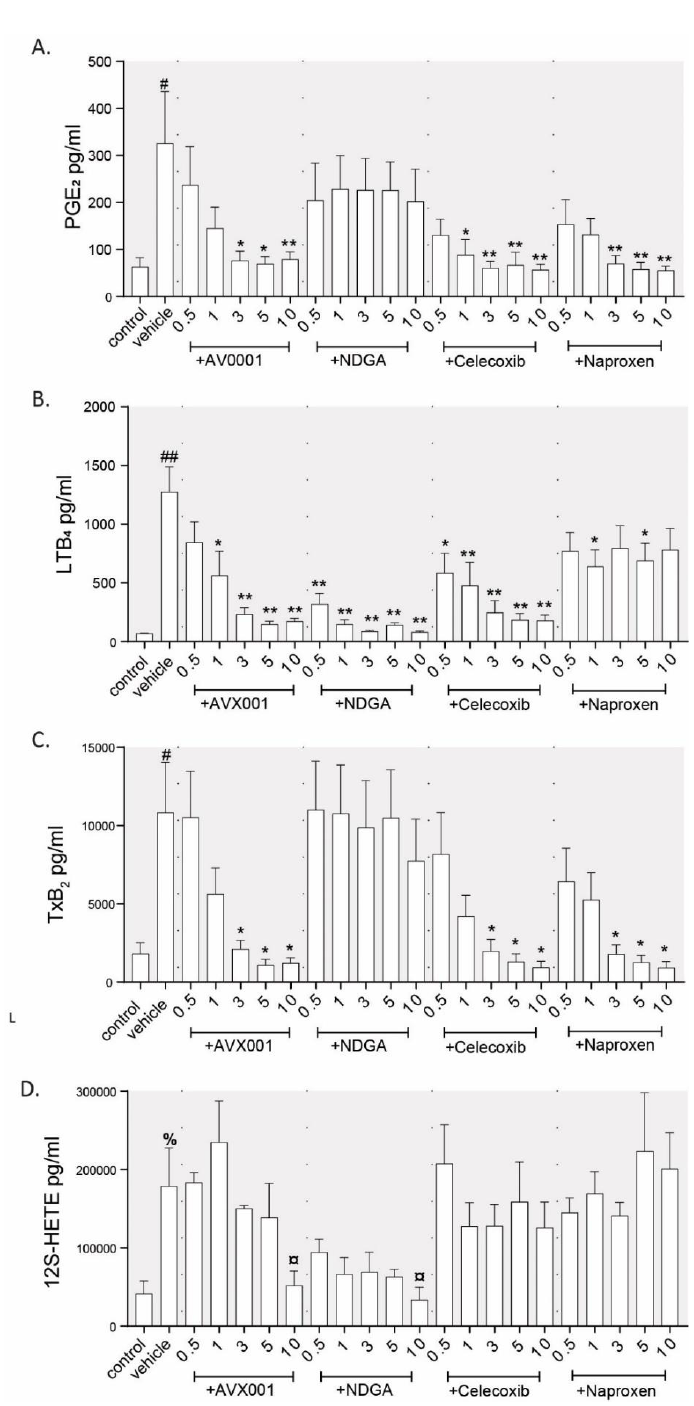
Figure A1. Inhibition of eicosanoid release in A23178-stimulated PBMC. Eicosanoid levels were measured in the supernatants of PBMC pre-incubated with vehicle, AVX001, naproxen, celecoxib, or NDGA in the range of 0.5 – 10 µM, and stimulated with A23178 (30 µM, 15 min). Data are the mean ± SEM for ( A ) PGE 2 , ( B ) LTB 4 , ( C ) TxB2, and ( D ) 12S-HETE from four individuals (PGE 2 , LTB 4 , TxB2) or three individuals (12S- HETE). Statistical significance was calculated using ANOVA with Dunnett’s post-analysis, whereby % p < 0.1, # p < 0.05, ## p < 0.01 versus unstimulated control and ¤ p < 0.1, * p < 0.05, ** p < 0.01 versus vehicle-treated control.